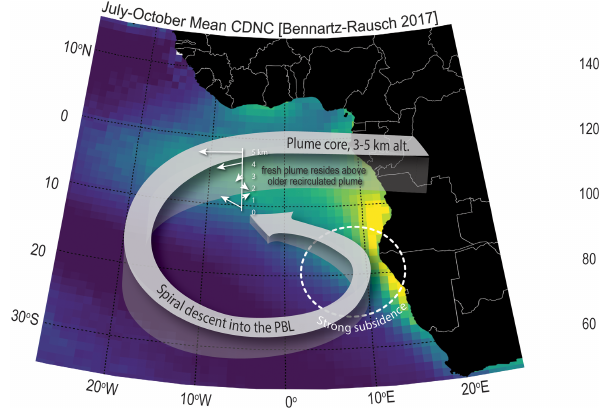
Figure 21. A schematic showing an example of a commonly oc- curring trajectory pathway into the marine PBL for smoke aerosol ejected from southern Africa in the core (3–5km altitude) of the southern African Easterly Jet (SAEJ). This is overlaid onto an August–October mean climatology of cloud droplet concentration (colors) derived using MODIS (Bennartz and Rausch, 2017). Tra- jectories over the SEA are variable. Depending upon the winds in the FT, the trajectory may remain relatively static or may (as in the case shown here) be advected as far south as 30 ◦ S and back toward the African continent by the incursion of midlatitude disturbances that lead to westerly lower tropospheric winds extending into tropi- cal